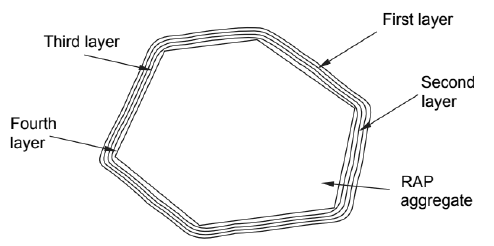
Figure 3. Layers of asphalt binder coating RAP aggregate [20].